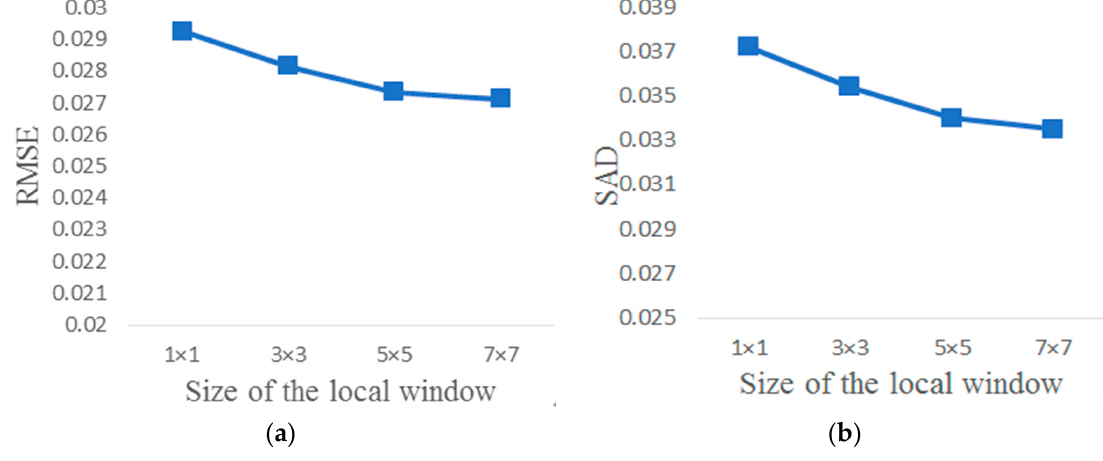
Figure 18. Experimental results with different sizes of the local window: ( a ) RMSE; ( b ) SAD.